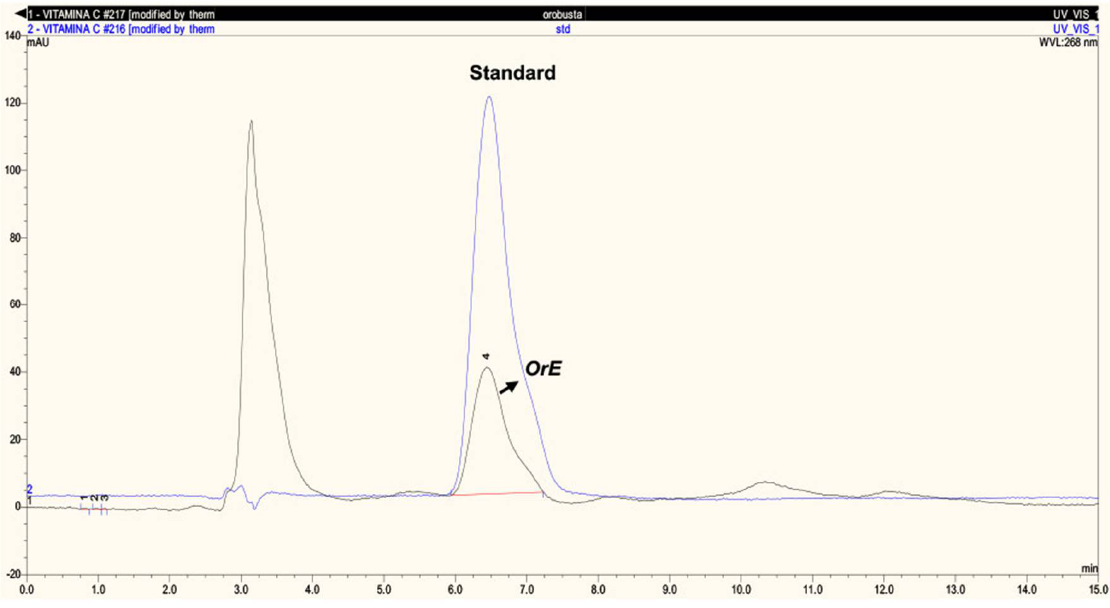
Figure 3. HPLC-UV chromatogram of vitamin C in OrE .